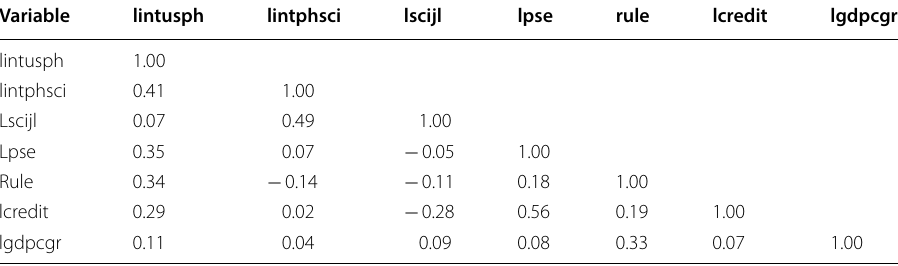
Table 2 Descriptive analysis. Source : computed by the authors INTUSPH INTPHSCI SCIJL RULE Median Minimum Skewness Observations 165